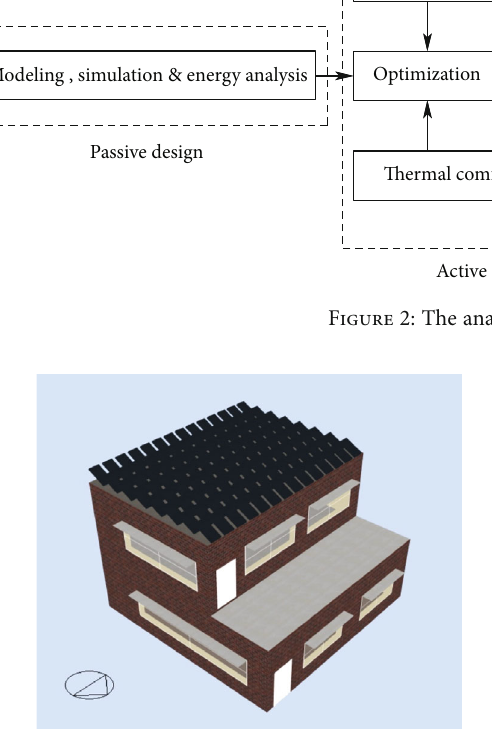
Figure 3: The modeled administrative building for